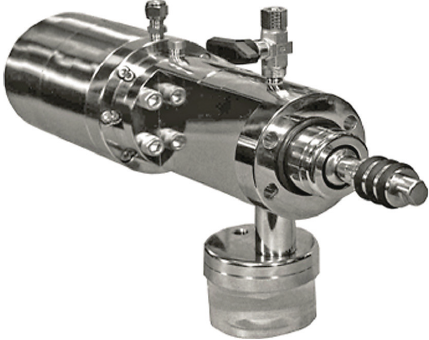
Fig. 12 Automatic Sampler for Tanks, Mixers, and Reactors. (Courtesy of Sentry Equipment www.sentry-equip.com)